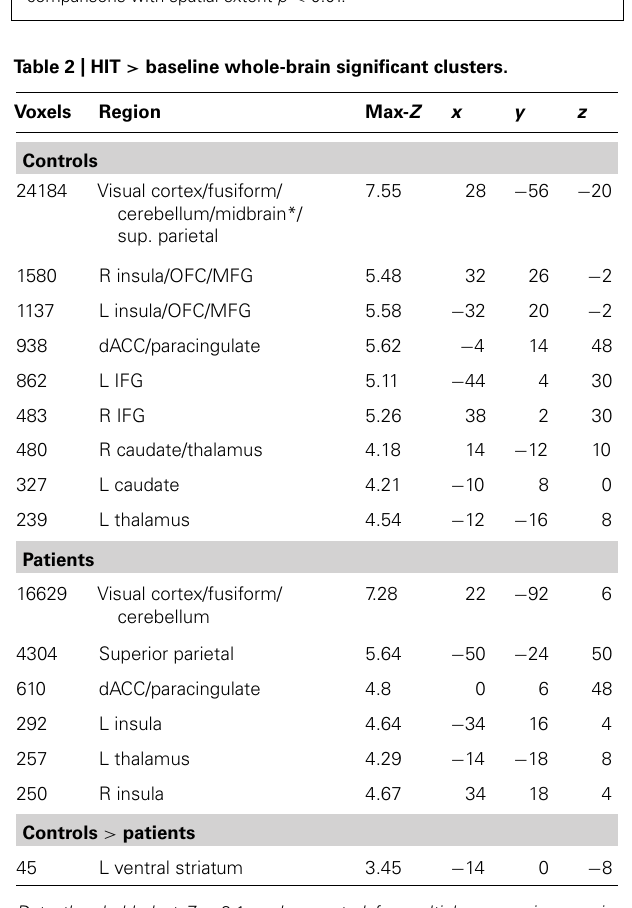
FIGURE 2 | Ventral striatum HIT > baseline ROI analysis. (A) Results in healthy controls. (B) Results from control > patient contrast. Images thresholded at Z > 2.3 and cluster corrected for multiple comparisons with spatial extent p < 0.01. Note: A similar cluster to that shown in (B) was the only significant result of the exploratory whole-brain controls > patients analysis. Left hemisphere shown on left side of images.